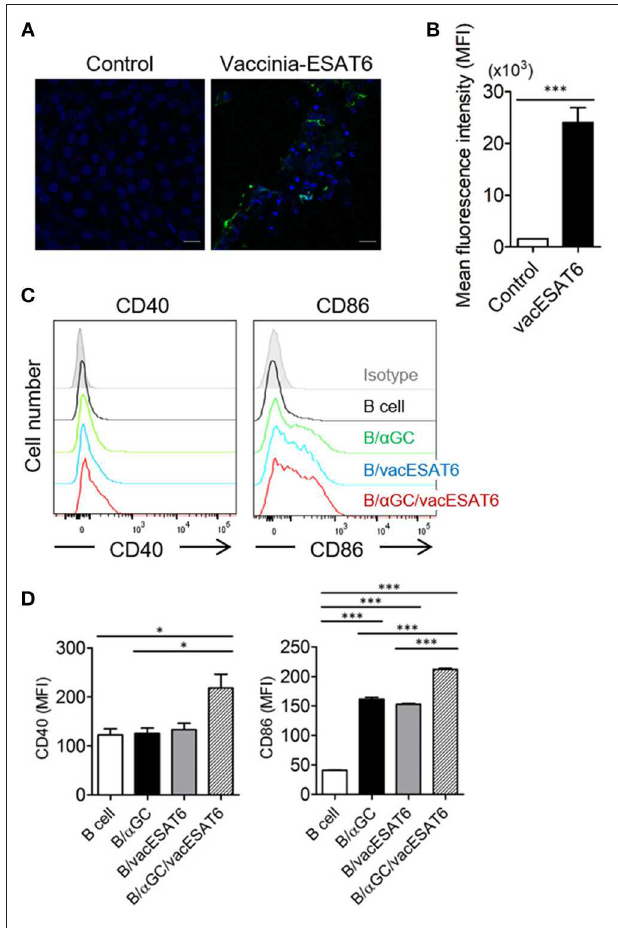
FIGURE 1 | B/ α GC/vacESAT6 up-regulates co-stimulatory molecules on B cells. (A,B) Vero cells were transduced with vaccinia-ESAT6 (vacESAT6) at a multiplicity of infection (MOI) of 1. Transduced cells were fluorescently stained for ESAT6 (green) and counterstained with DAPI (blue) for nuclei which were analyzed by confocal microscopy to detect the expression of ESAT6 (scale bar = 20 µ m). (A) Representative confocal images and (B) Representation of the evaluation of green fluorescent area. (C,D) B220 + cells were isolated from splenocytes of naïve C57BL/6 mice. Isolated B220 + cells were transduced with vacESAT6 at a MOI of 1 and/or loaded with 1 µ g/ml of α GC and then co-cultured with naïve splenocytes for 24h. Incubated cells were stained to examine the expression of B220, CD40, and CD86. Expression levels of CD40 and CD86 in B220 + cells were analyzed by flow cytometry. (C) Representative flow cytometry histogram and (D) summary of mean fluorescence intensity of CD40 and CD86 expression in B cells. ANOVA. * p < 0.05, *** p <